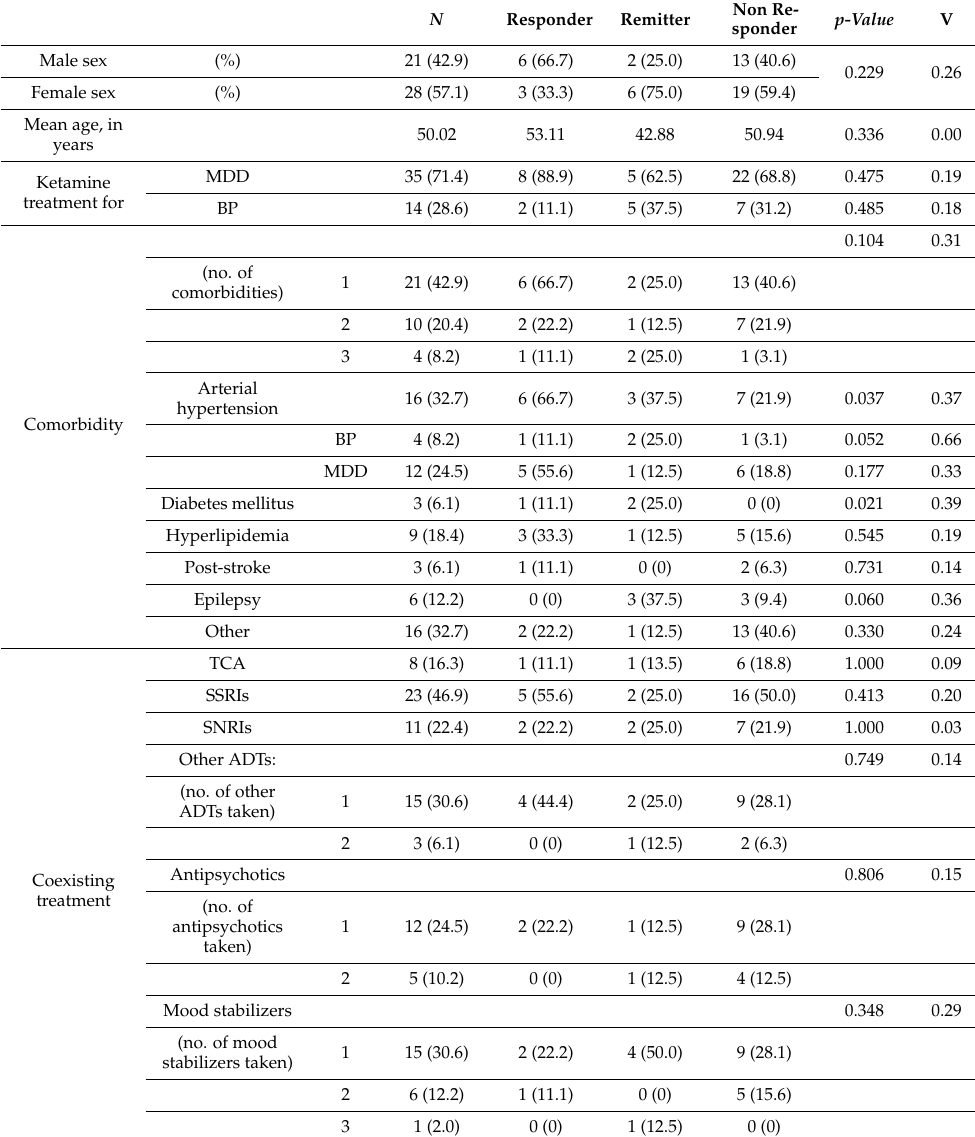
Table 1. Demographic and clinical variables.